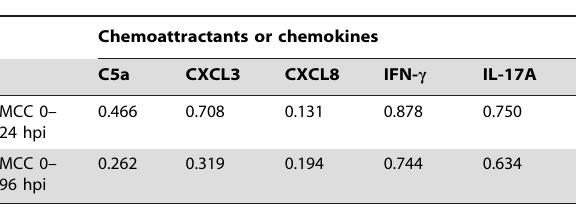
Table 2. Correlations between milk cell concentrations (MCC) and concentrations of the chemoattractants and pro- inflammatory cytokines that were detected in the milk of all the responder